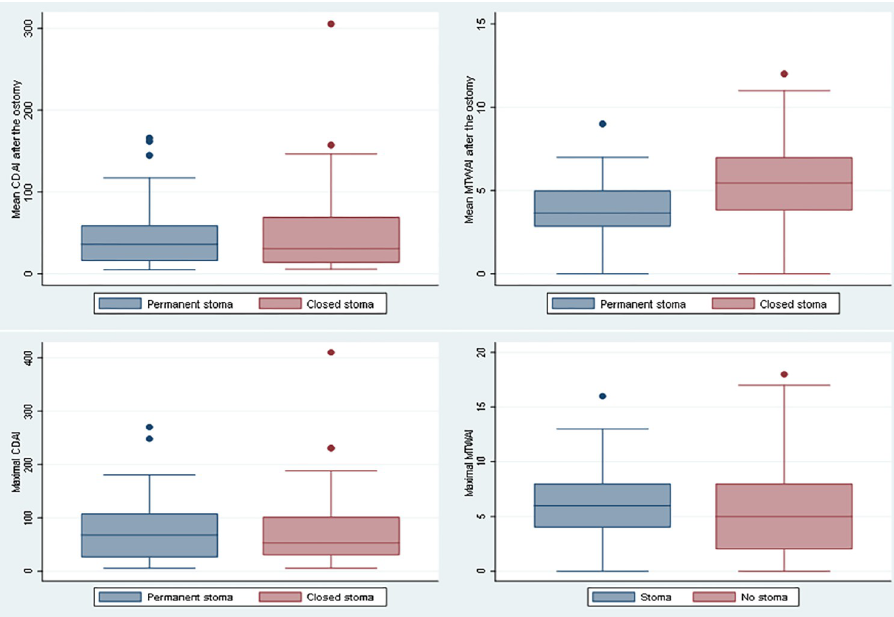
Fig 2. Mean and maximal disease activity in permanent vs. closed stoma in patients with Crohn’s Disease and patients with Ulcerative colitis.